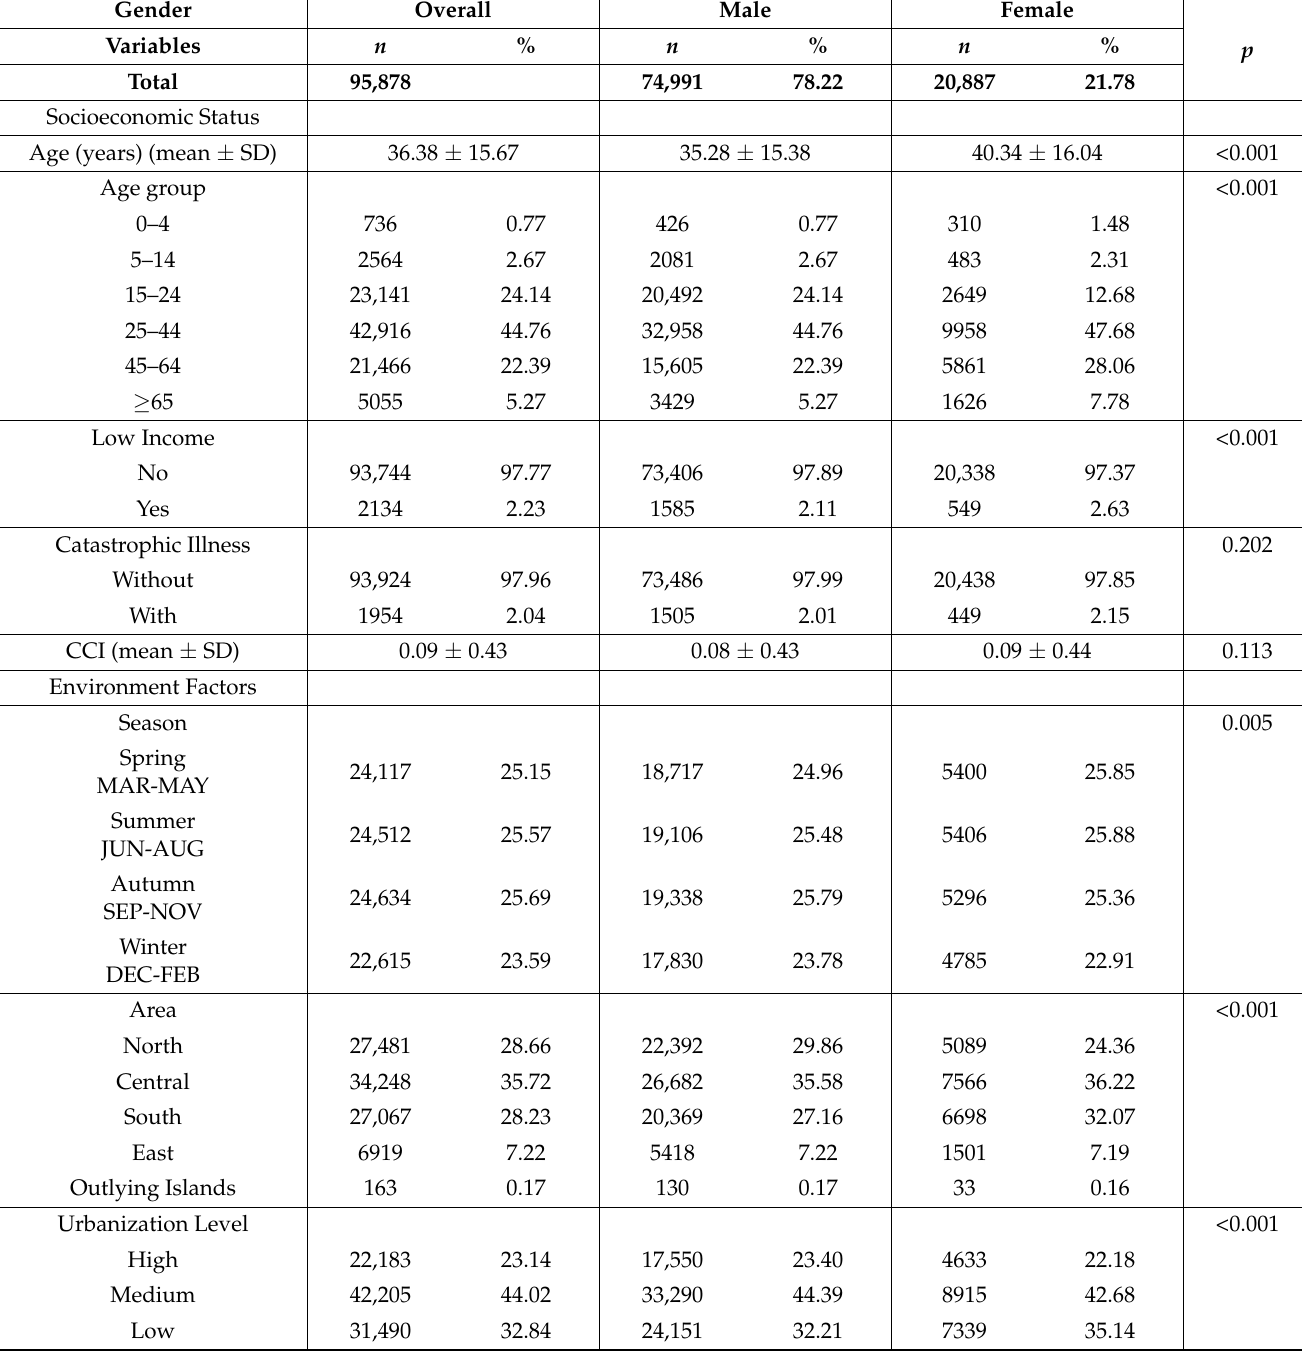
Table 1. Characteristics of homicide inpatients between 1998 and 2015 in